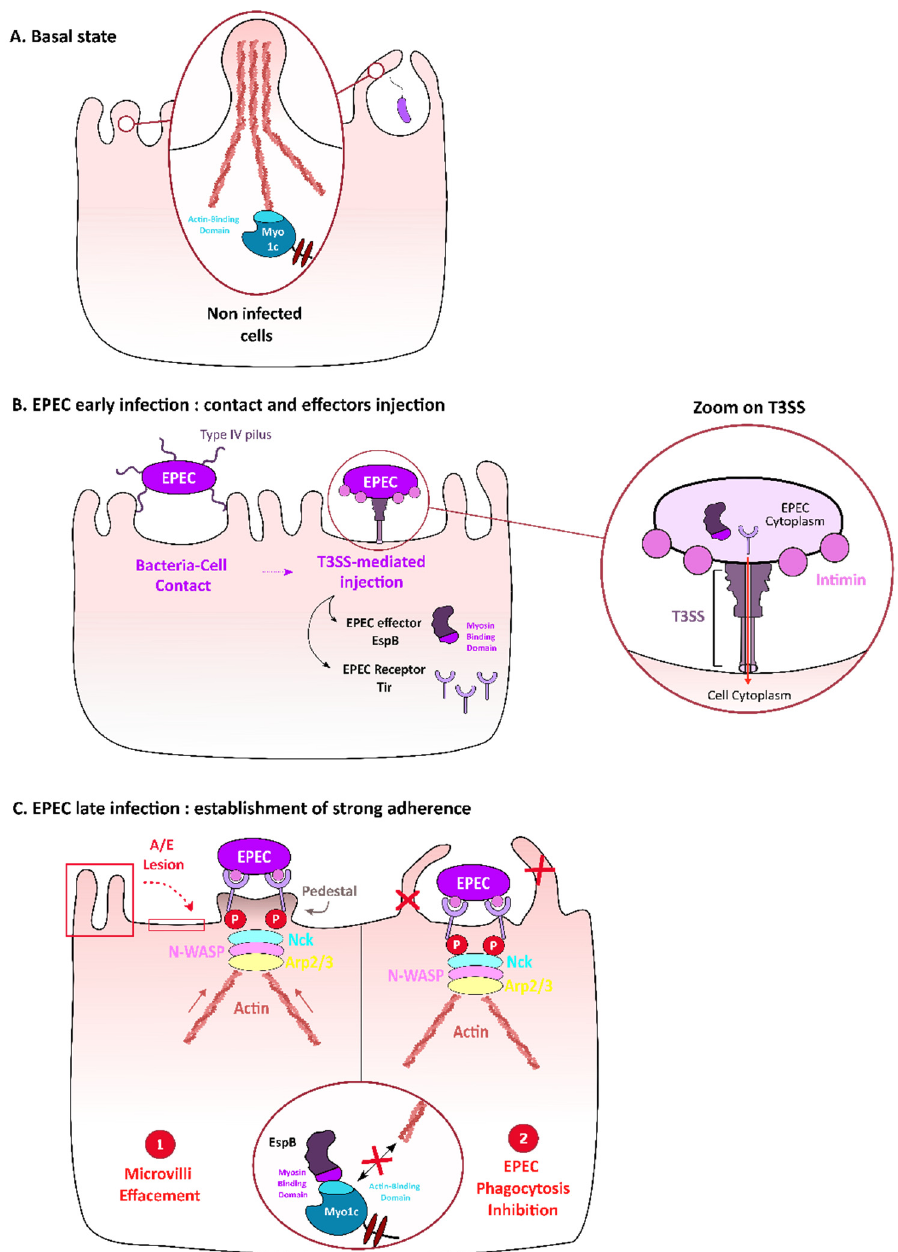
Figure 2. Role of Myo1c in enteropathogenic E.coli (EPEC) adhesion on intestinal epithelial cells surface and in evasion from phagocytosis. Microvilli and phagocytic extensions rely on the actin cytoskeleton, in particular on myosin Ic that interacts with actin ( A ). When EPEC infects intestinal epithelial cells, the bacterial Tir receptor is injected by EPEC’s Salmonella typhimurium Type 3 secretion system (T3SS) and then presented at the cell host surface to interact with the EPEC envelop protein intimin. T3SS is a molecular device that allows the injection of bacterial proteins inside the host cell cytoplasm (zoom) ( B ). This interaction triggers actin polymerization under the bacterial adhesion site through activation of the Nck/N-WASP/Arp2/3 pathway, thus leading to the formation of a platform called “pedestal” (C1). The effector EspB also injected inside the host cell by the T3SS (B), competes with actin for myosin-binding ( C ). In epithelial cells, this interaction destabilizes microvilli, thus contributing to attaching-effacing lesions (C1); in macrophages, this interaction inhibits phagocytic structure extension, thus leading to inhibition of phagocytosis (C2).